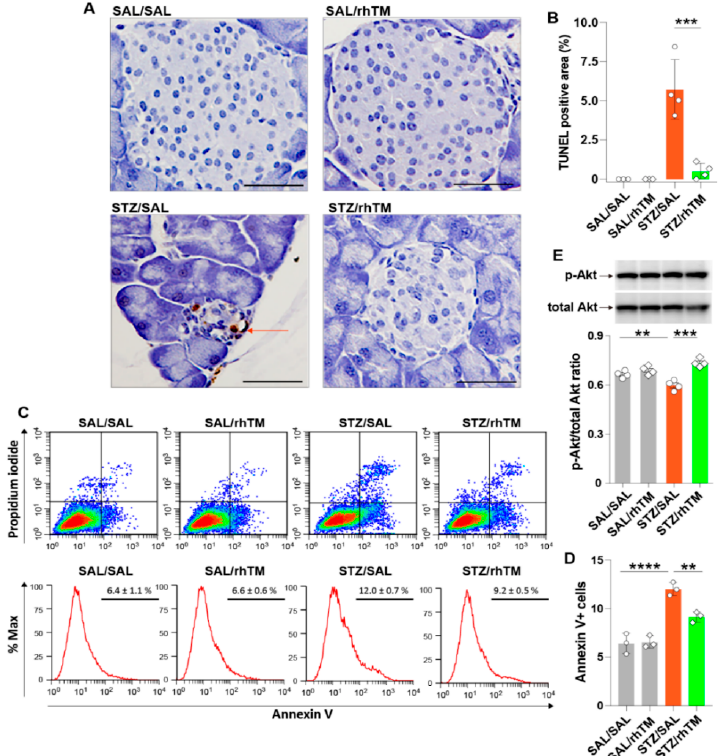
Figure 5. Recombinant human thrombomodulin inhibited apoptosis of pancreatic β -cells in diabetic mice. ( A ) Staining of pancreatic islet cells by TUNEL assay. Scale bars indicate 50 µm. ( B ) TUNEL- positive pancreatic islet areas measured by WinROOF image processing software. SAL/SAL, mice intraperitoneal injection of SAL and were treated with recombinant human thrombomodulin (rhTM). STZ/SAL, mice received intraperitoneal injection of streptozotocin (STZ) and were treated with